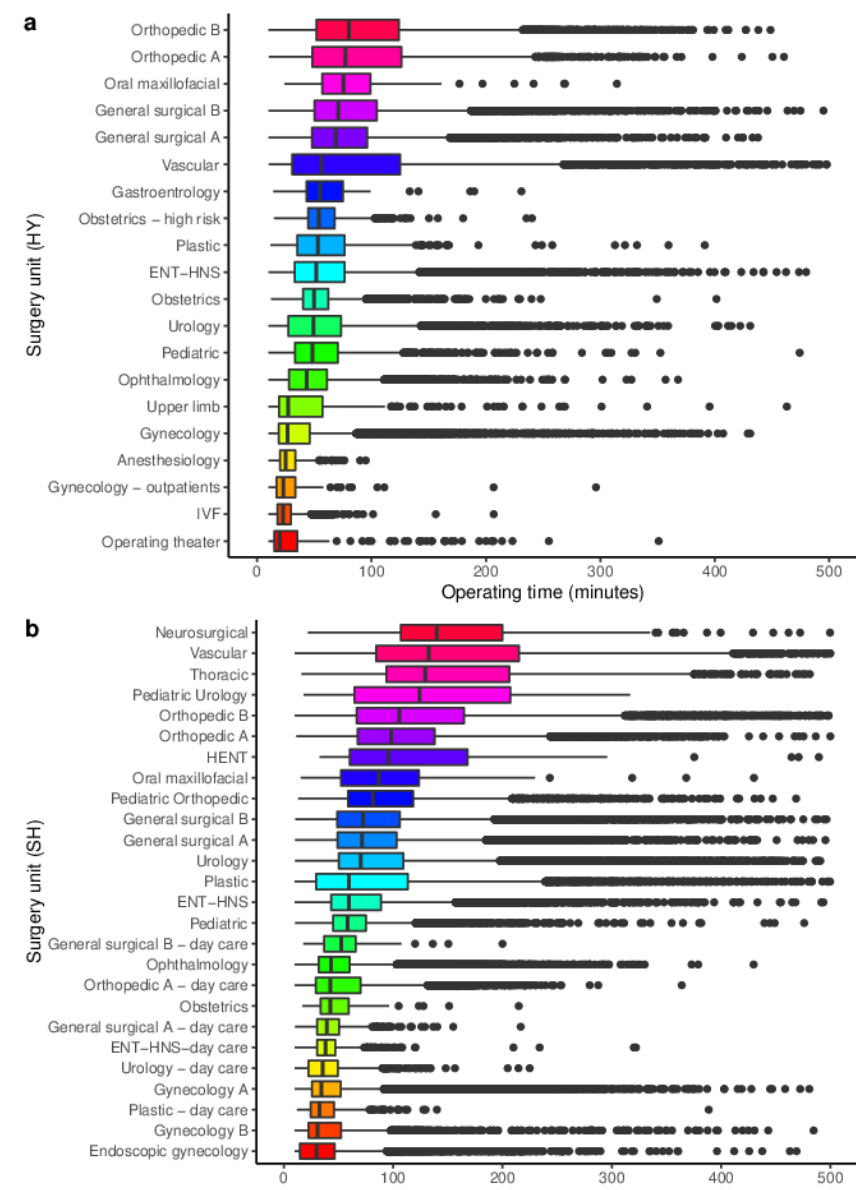
Figure 3. Box plots representing the distributions of surgery lengths by surgical units and by hospital, ( a ) HY and ( b ) SH. Each box represents the 3rd to 4th quartile range, and the vertical bar represents the median duration. Surgeries longer than 500 min were removed from this figure. Surgical units were sorted on the Y-axis by median